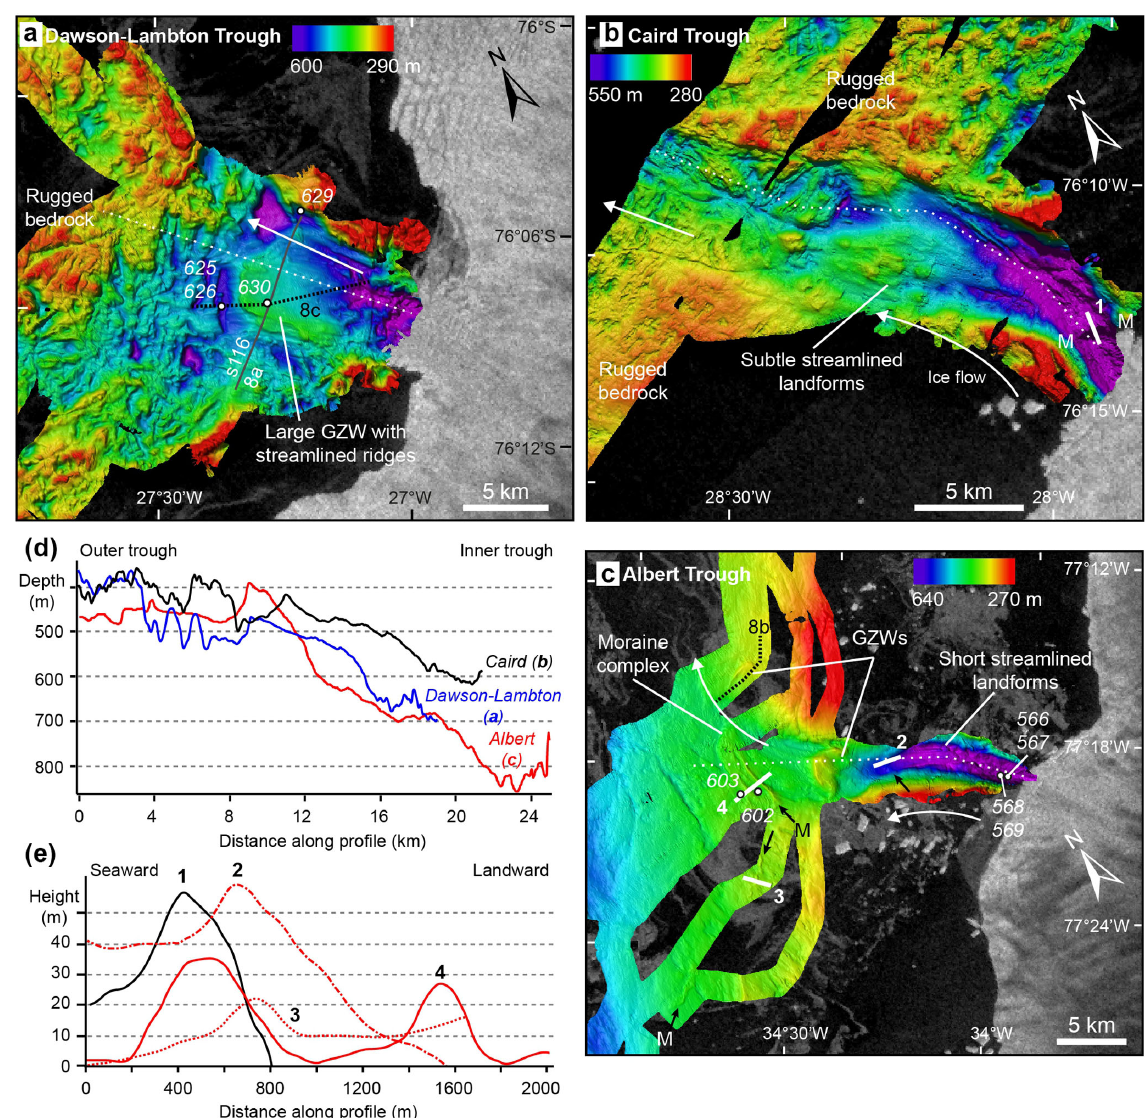
Figure 3. Geomorphology of glacial troughs downstream of high-velocity glaciers (250–500myr − 1 ) . Background image is an Envisat synthetic aperture radar image from 21 February 2011 to show the position of the ice front during the survey (cruise JR244). (a) Dawson- Lambton Trough, black line shows the location of seismic-reflection profile BAS101-s116 along the strike of the large grounding-zone wedge (GZW, shown in Fig 8a), (b) Caird Trough and (c) Albert Trough, with labelled examples of streamlined landforms, moraines (arrowed and labelled “M”) and GZWs. (d) Long profiles down the central axis of the troughs showing landward-dipping geometries; profile locations are marked with white dotted lines in panels (a) , (b) and (c) . (e) Cross profiles over prominent ridge features interpreted as moraines; profile locations are marked with solid white lines in panels (b) and (c) . Sediment core locations are marked by white circles with associated core